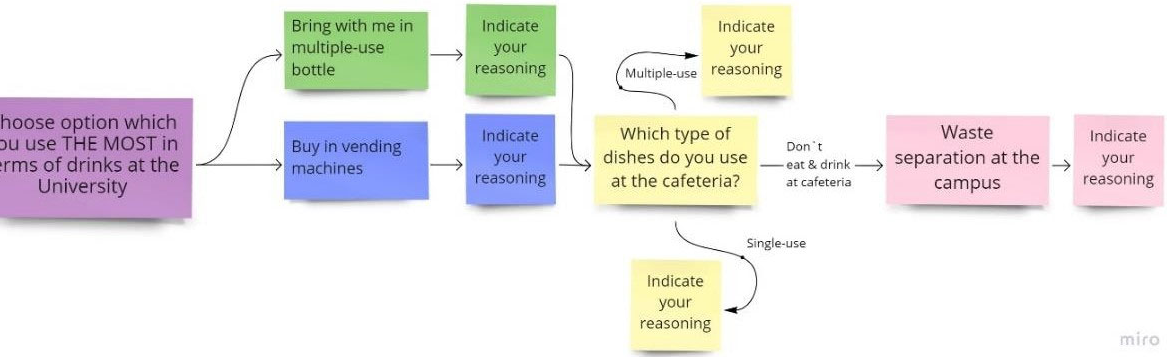
Table 20. Index system for types of transport.